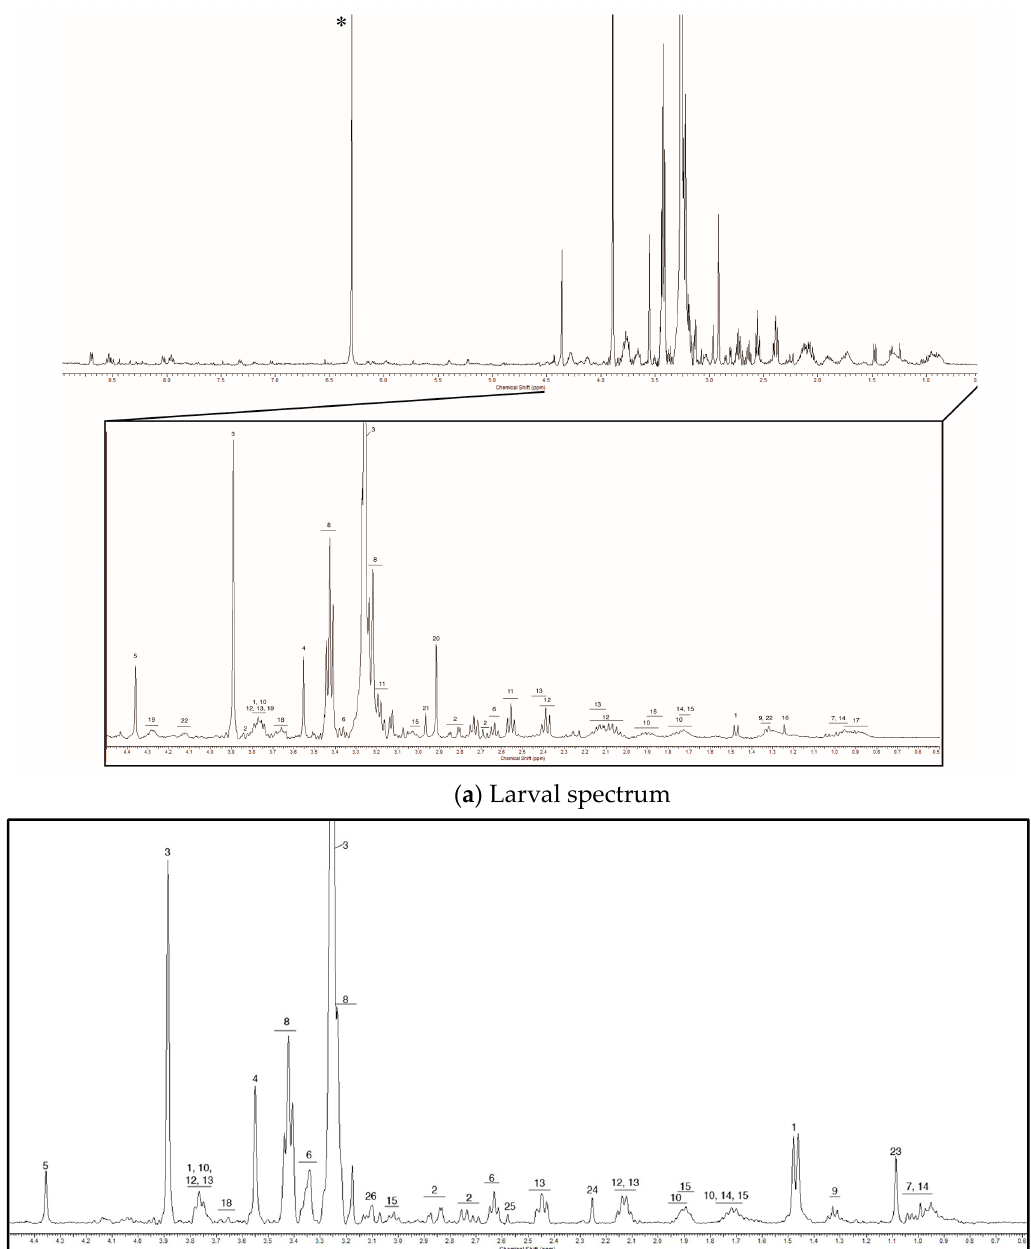
Figure 2. A representative 1D 1 H NMR spectra for larval ( a ) veliger and juvenile ( b ) mantle tissue mussels are shown over the 0–9 ppm range, with a focus on the 0–4.5 ppm range where the chemical shifts for most of the metabolites we detected are found. The numbers above each peak correspond to the metabolites listed in Table 1. The spectra are referenced to the chemical shift of trimethylsilylpropanoic acid (TSP) (0 ppm). The asterisk in panel a marks the chemical shift for the maleic acid spike (6.29 ppm) that was used for relative quantification.